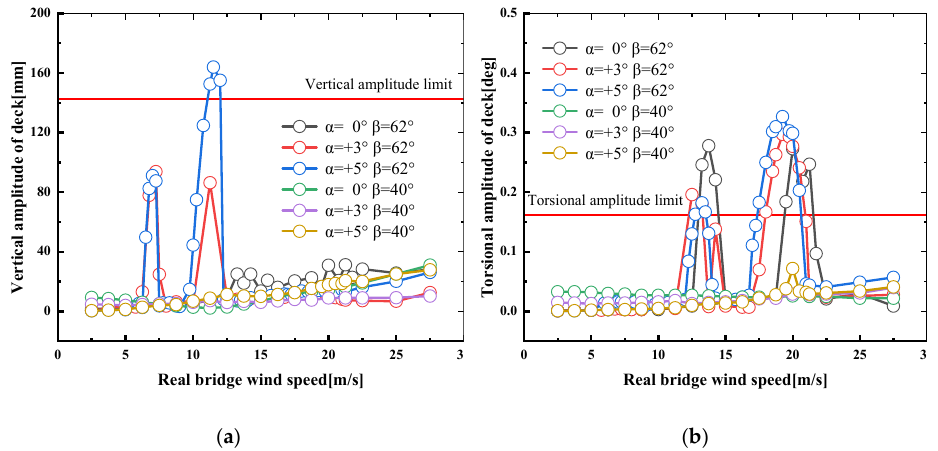
Figure 12. The effect of wind fairing angle on VIV in the service stage. ( a ) Vertical; ( b ) torsional.